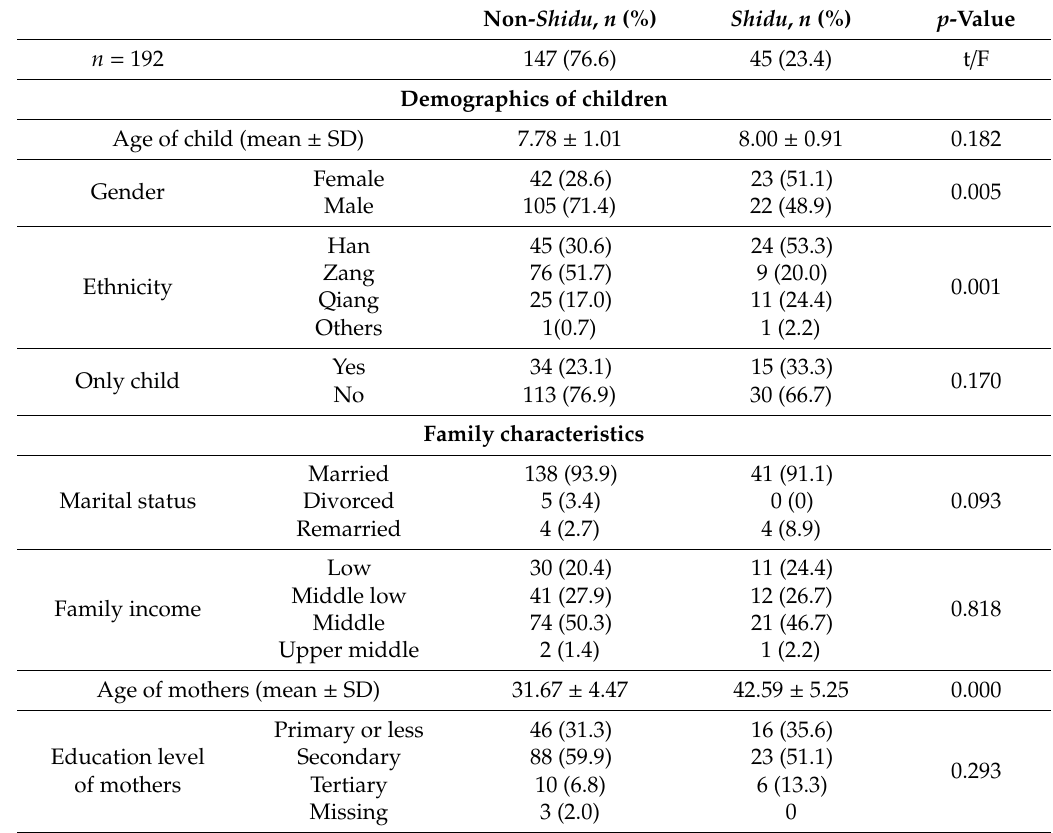
Table 1. Descriptive statistics for the demographics of children and their family